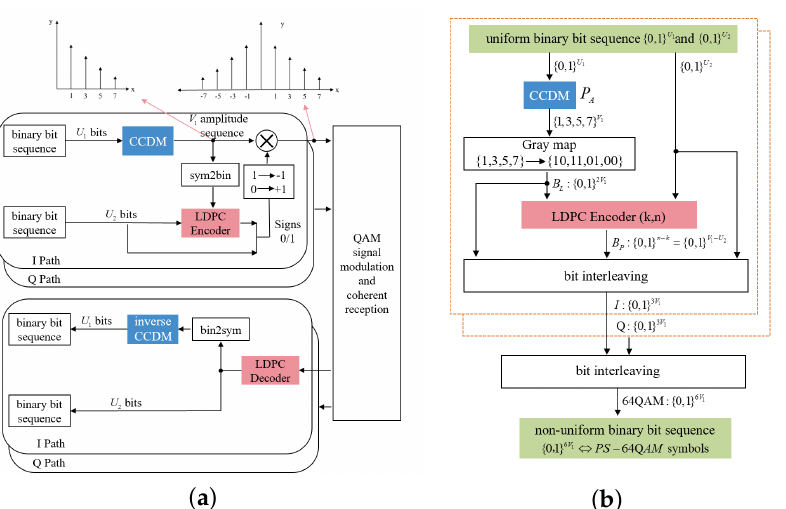
Figure 1. ( a ) The principle diagram of probability amplitude shaping using a CCDM and LDPC. ( b ) Bit sequence generation process of PS-64QAM